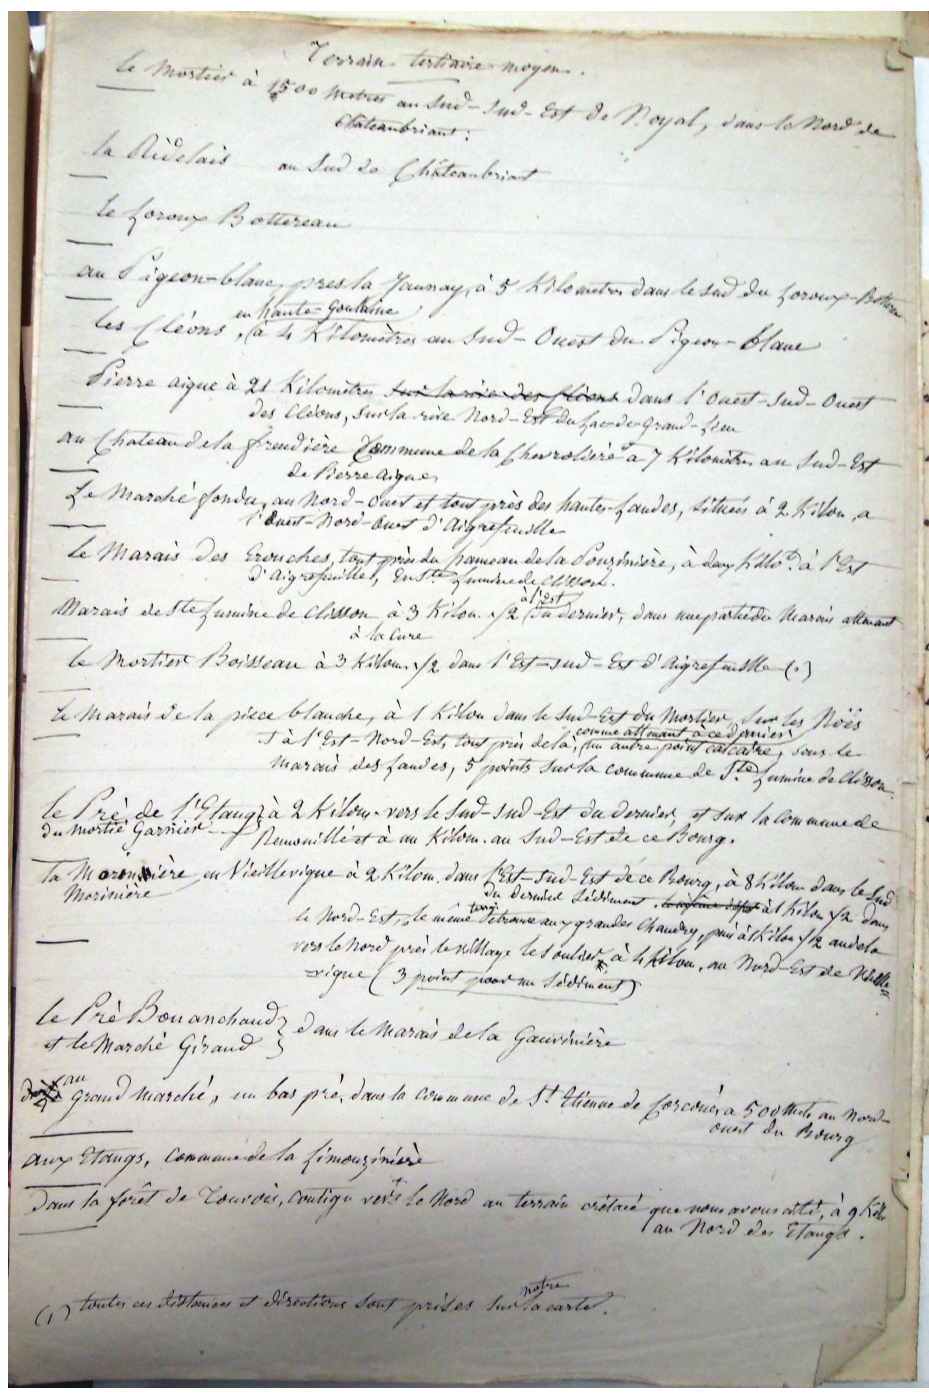
Figure 3: List of “Medium tertiary terrains.” MHNN, 2R842, undated,